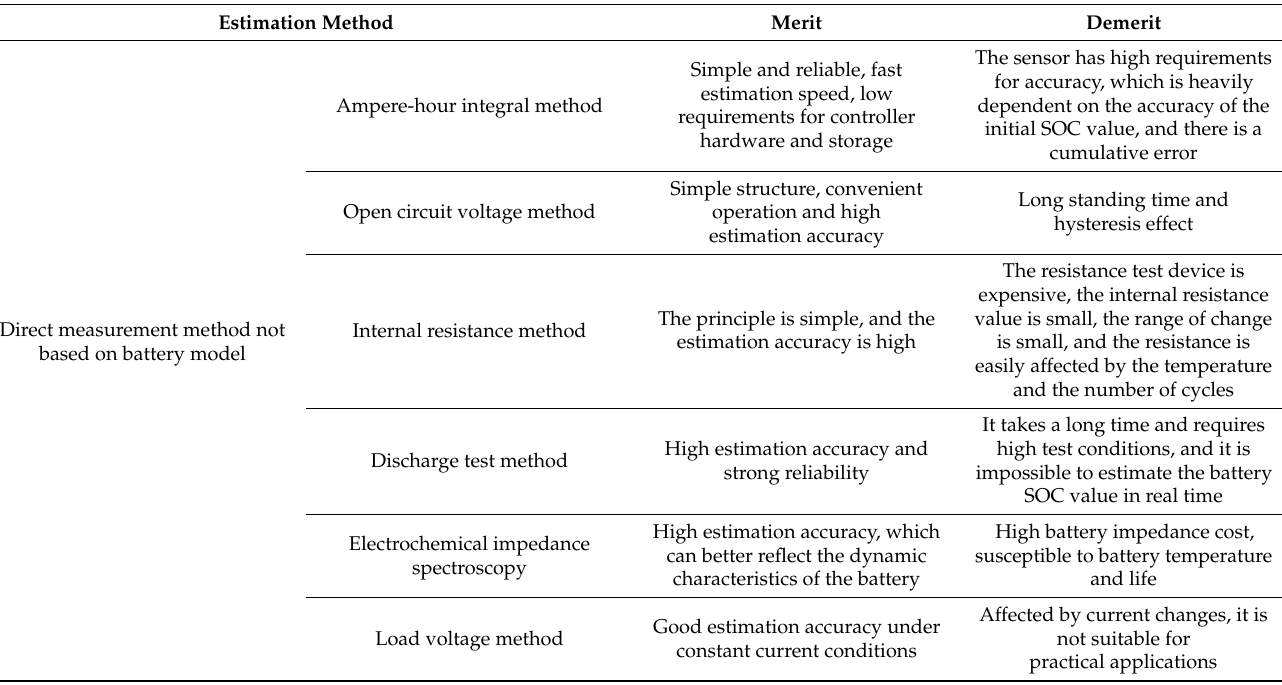
Table 3. Comparison of SOC estimation